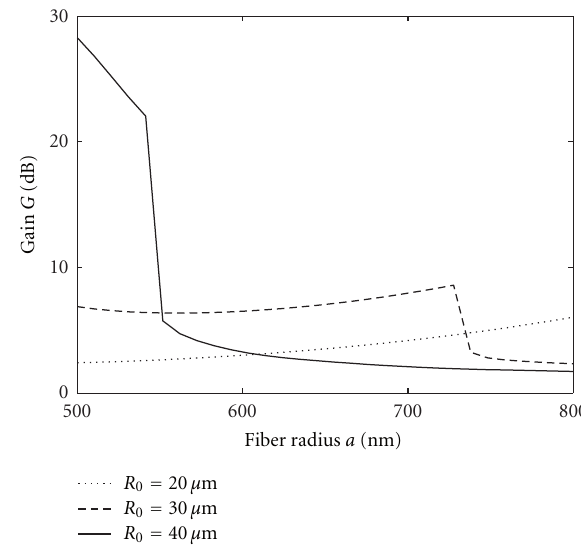
Figure 5: Signal amplification as a function of the taper angle for three di ff erent values of the waist fiber